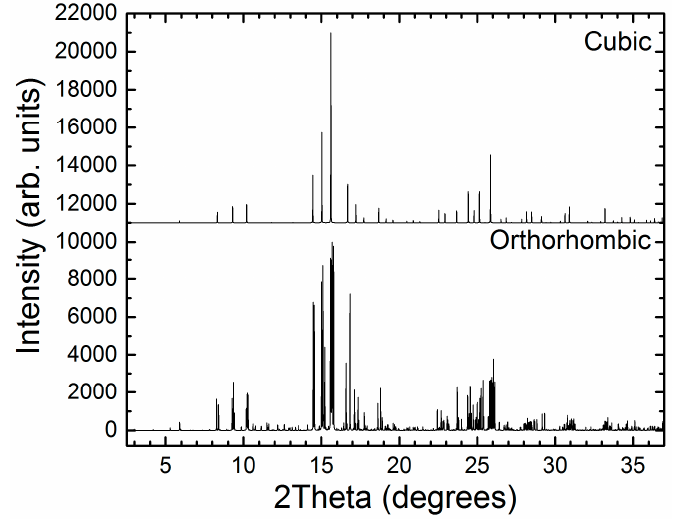
Figure 1. Clathrate-I unit cell of the large orthorhombic supercell with isolated M and P sites (blue, and yellow, respectively) and small cubic subcell (central blue square). Ba atoms are shown in red.